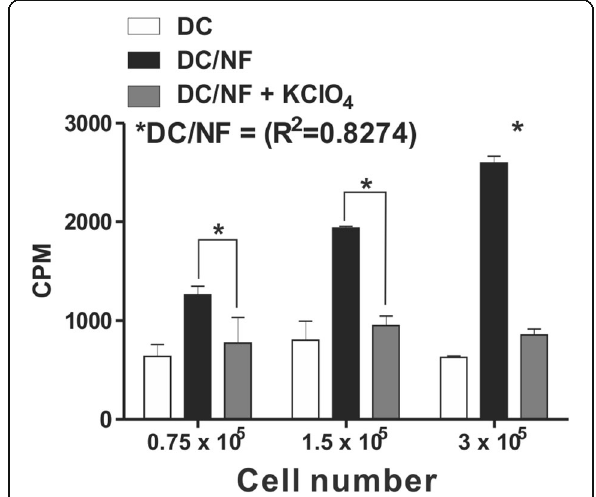
Fig. 2 In vitro 18 F-TFB uptake into DC and DC/NF cells. Data are means± S.D., n =